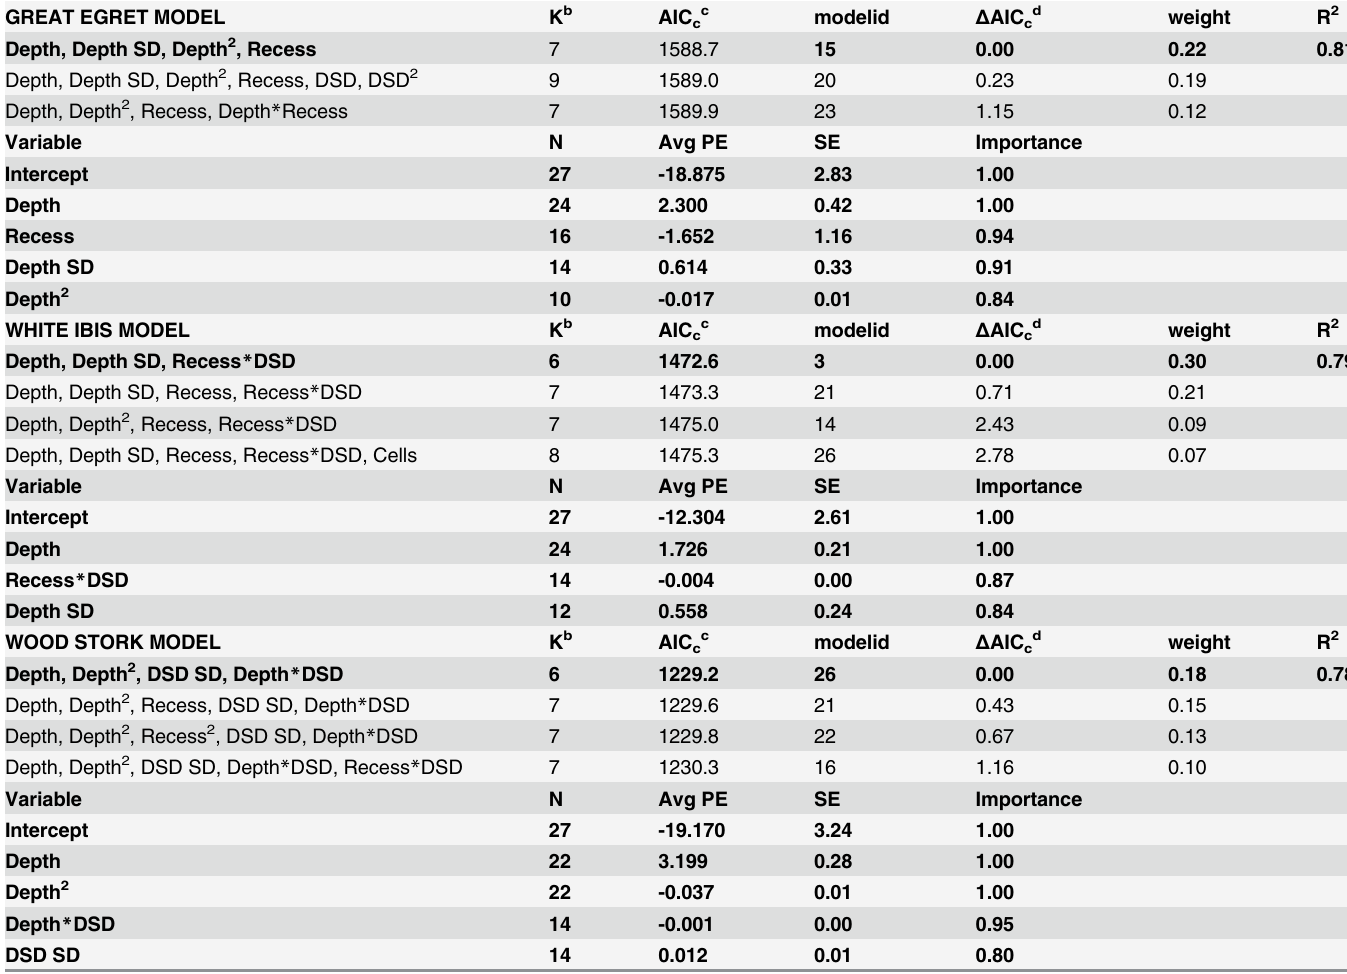
Table 1. Ranking of candidate models describing variables influencing daily mean depth use of Great Egrets, White Ibises, and Wood Storks in the Florida Everglades (Proc